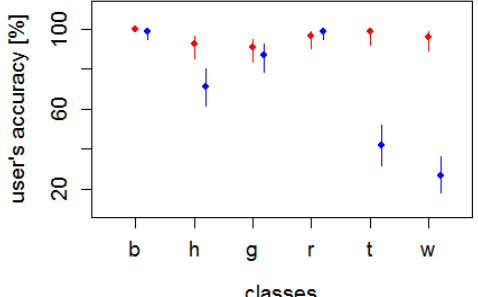
Figure 7. User’s accuracy with confidence intervals for two types of checkpoints, sample size: n c =91, classification method: SVM. (Red=Training, Blue=Independent). Abbreviations for classes are explained in Table 2.